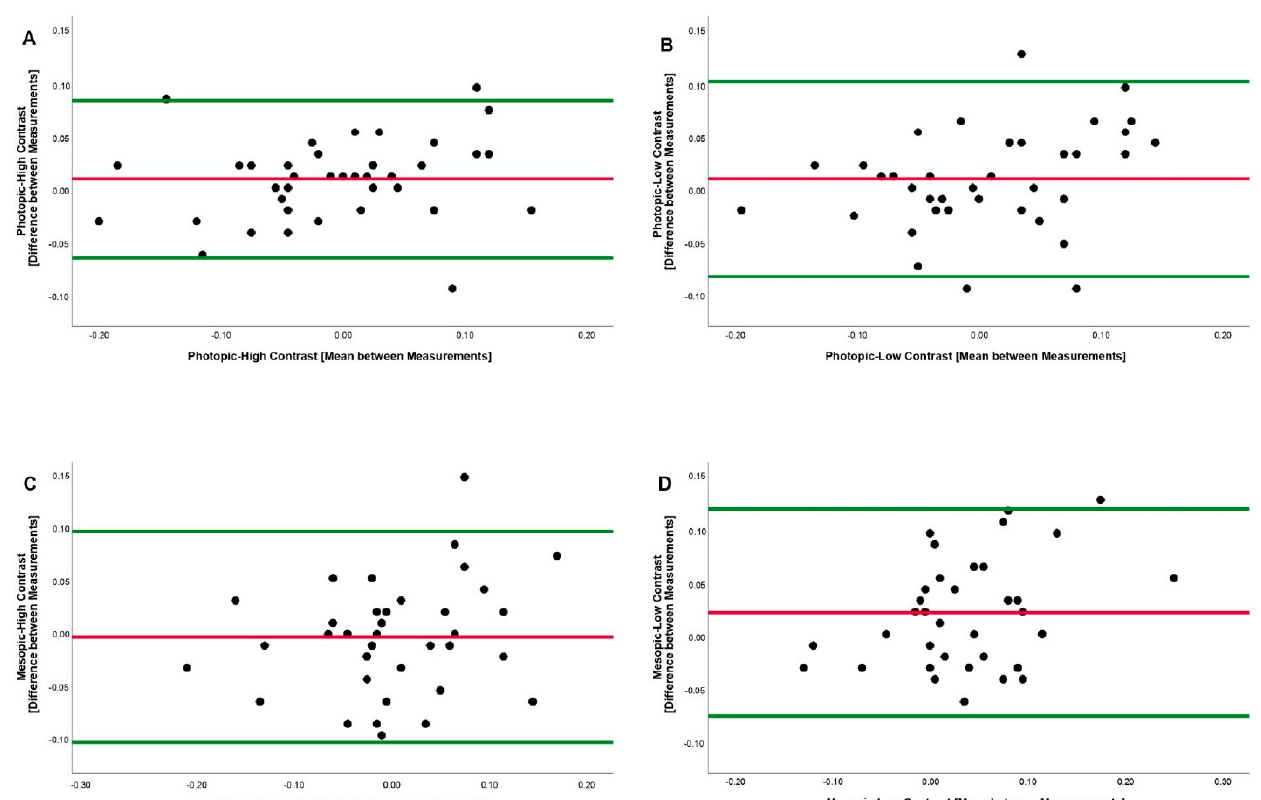
Figure 1. Bland–Altman plots between the measurements of VA. ( A ) Photopic and High Contrast; ( B ) Photopic and Low Contrast; ( C ) Mesopic and High Contrast; ( D ) Mesopic and Low Contrast. The central line indicates the mean between measurements. The external lines indicate limit of the 95 % agreement superior and inferior.